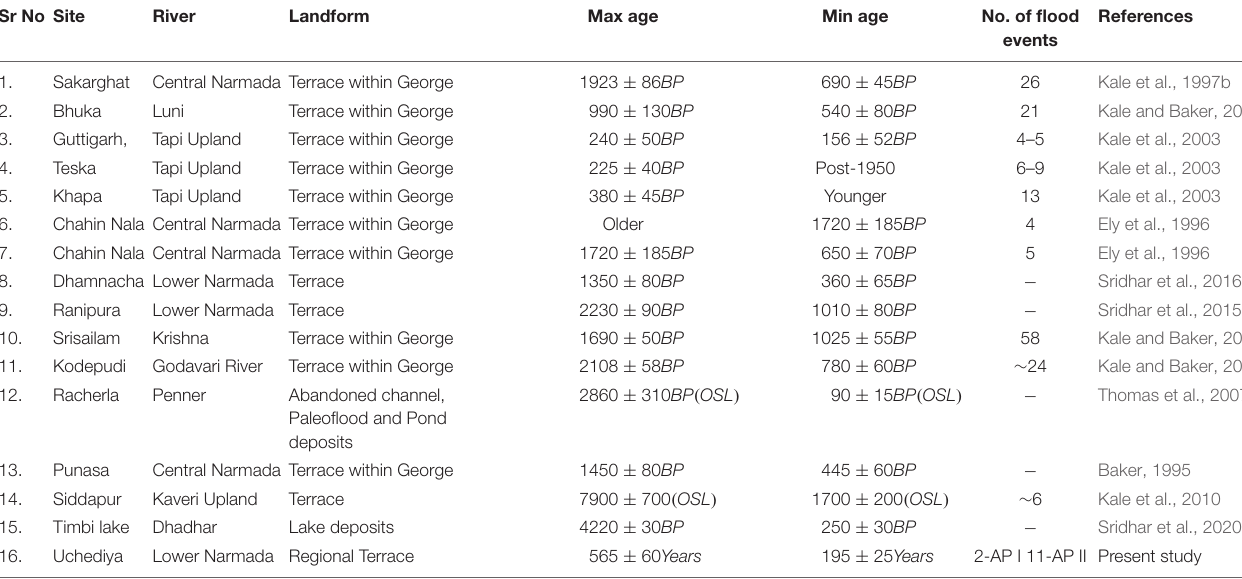
TABLE 1 | Various flood sequence sites studied along monsoonal rivers across the Indian subcontinent. Sr No